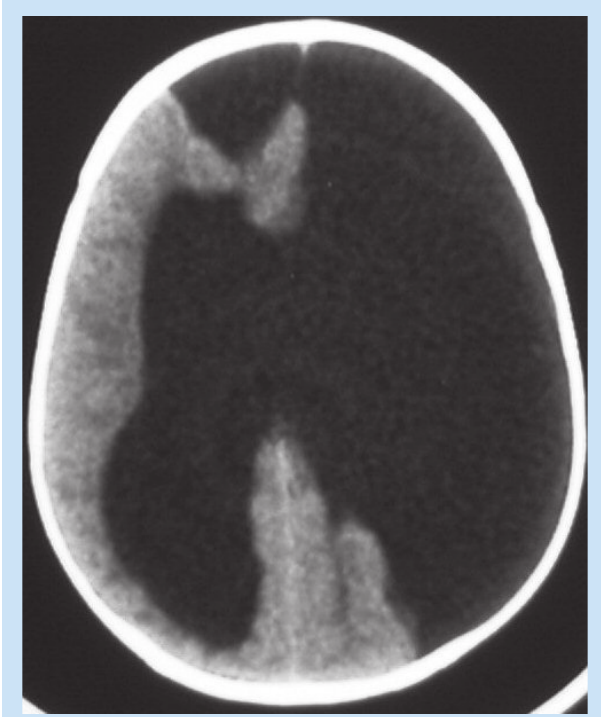
multicystic areas of predominantly white matter destruction. The ventricular outlines are